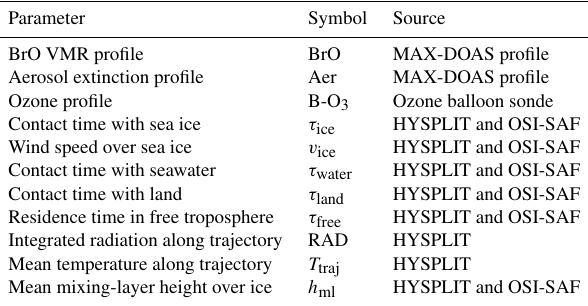
Table 5. Columnar parameters included in the regression